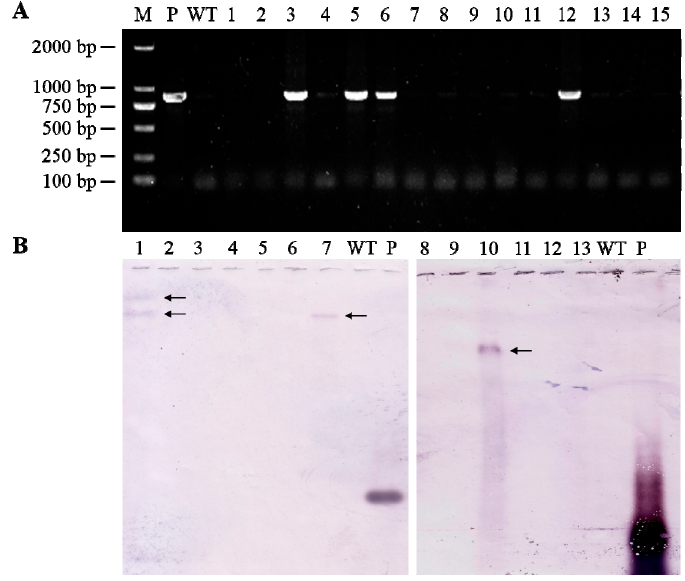
Figure 2. Analyses of wheat lines transformed with pWM101-EU586278 using PCR and southern blot methods. ( A ) PCR analysis of genomic DNA with Hyg gene. M, DL2000 marker; P, plasmid pWM101-EU586278 (positive control); WT, the untransformed wild plant (negative control); lines 1–15, wheat plants transformed with pWM101-EU586278; ( B ) Southern blot. Lines 1–13, thirteen randomly